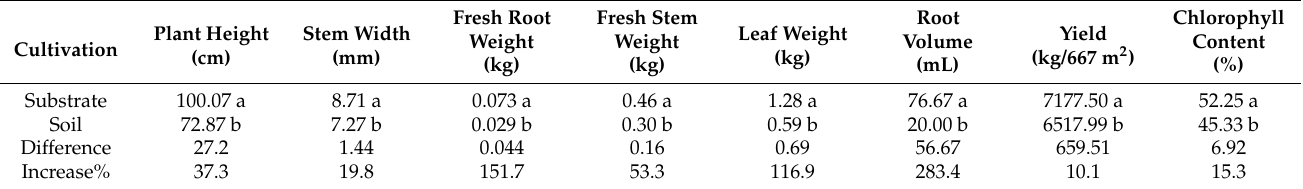
Table 4. Tomato growth and yield under substrate and soil cultivation